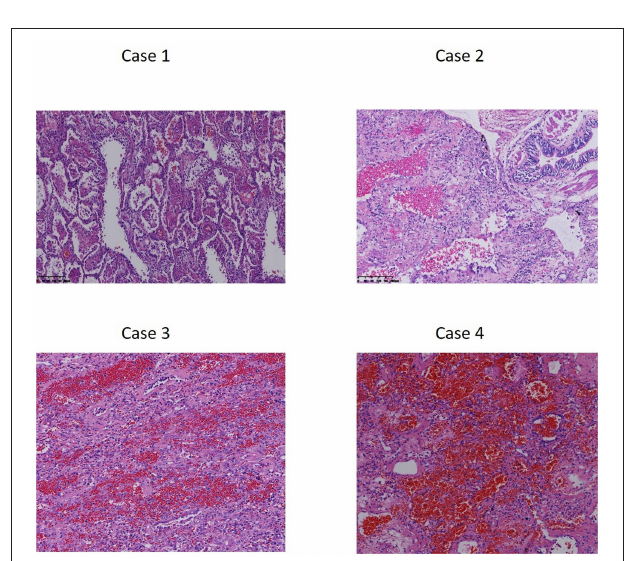
FIGURE 3 | Pathology examination of explanted lung tissue after herbicide intoxication. Massive fibroblastic tissue obliterated the lung architecture, with extensive effusions, capillary congestion, inflammatory cell infiltration, alveolar edema, and hyaline membrane formation, could be observed with varied extent of severity in Case